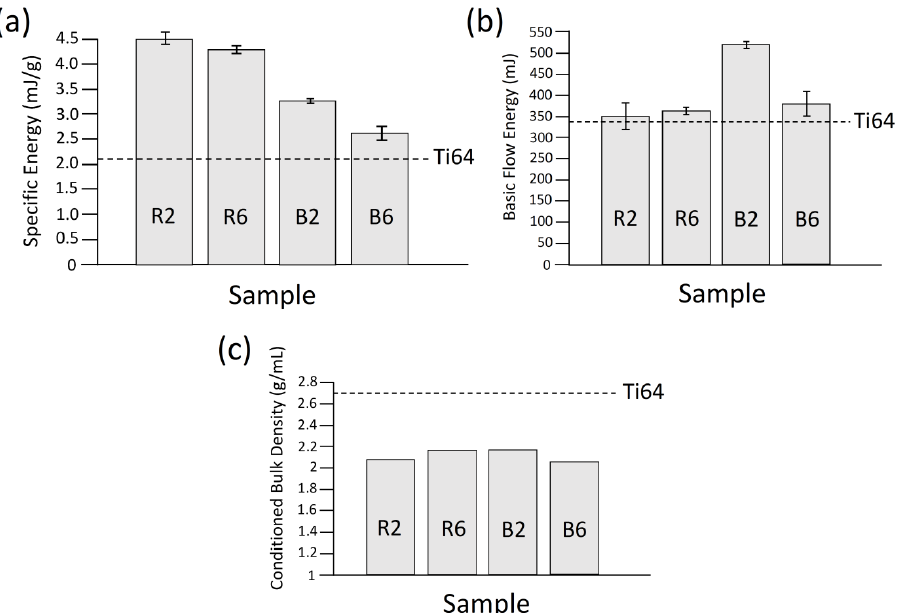
Figure 9. The flow behavior and conditioned bulk density results for 5 wt.% B 4 C/Ti ‐ 6Al ‐ 4V